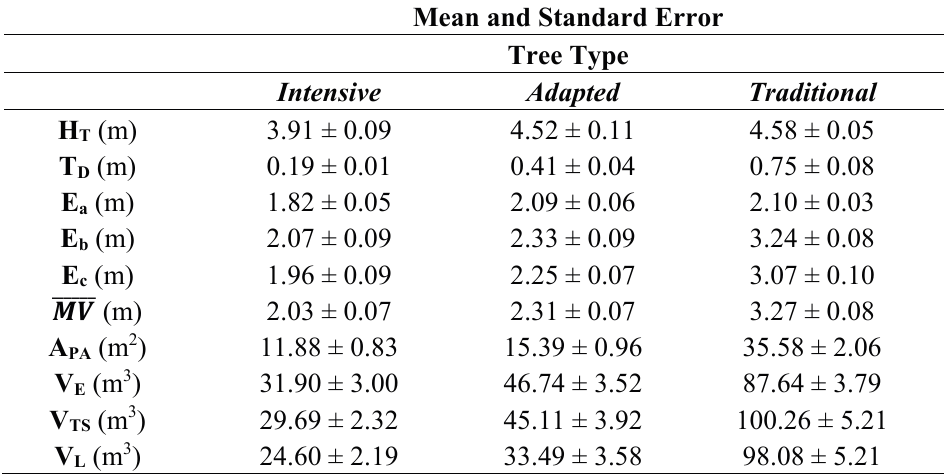
Table 2. Mean and Standard Error of all parameters for each tree